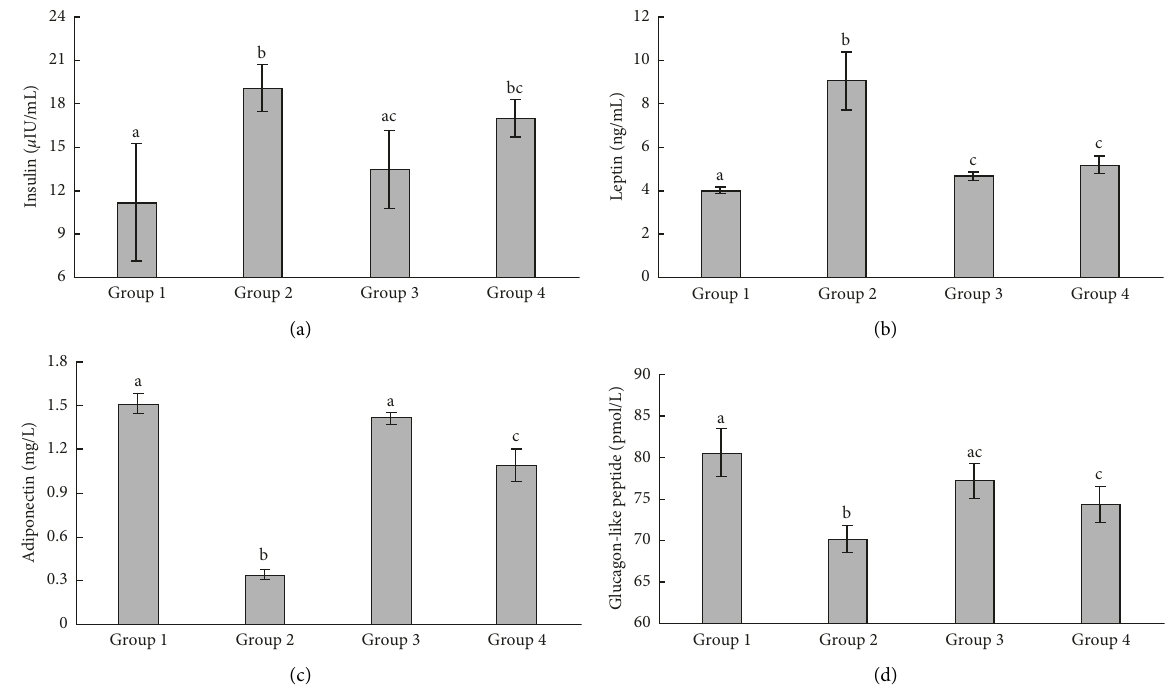
Figure 3: Effects of SDF on the concentration of hormones in nondiabetic and diabetic mouses. Data are expressed as mean ± standard deviation (SD). Values with different letters are significantly different, p ≤ 0 . 05. Group 1: nondiabetic group; Group 2: diabetes model group; Group 3: metformin group; Group 4: SDF group. (a) Insulin. (b) Leptin. (c) Adiponectin. (d) Glucagon-like